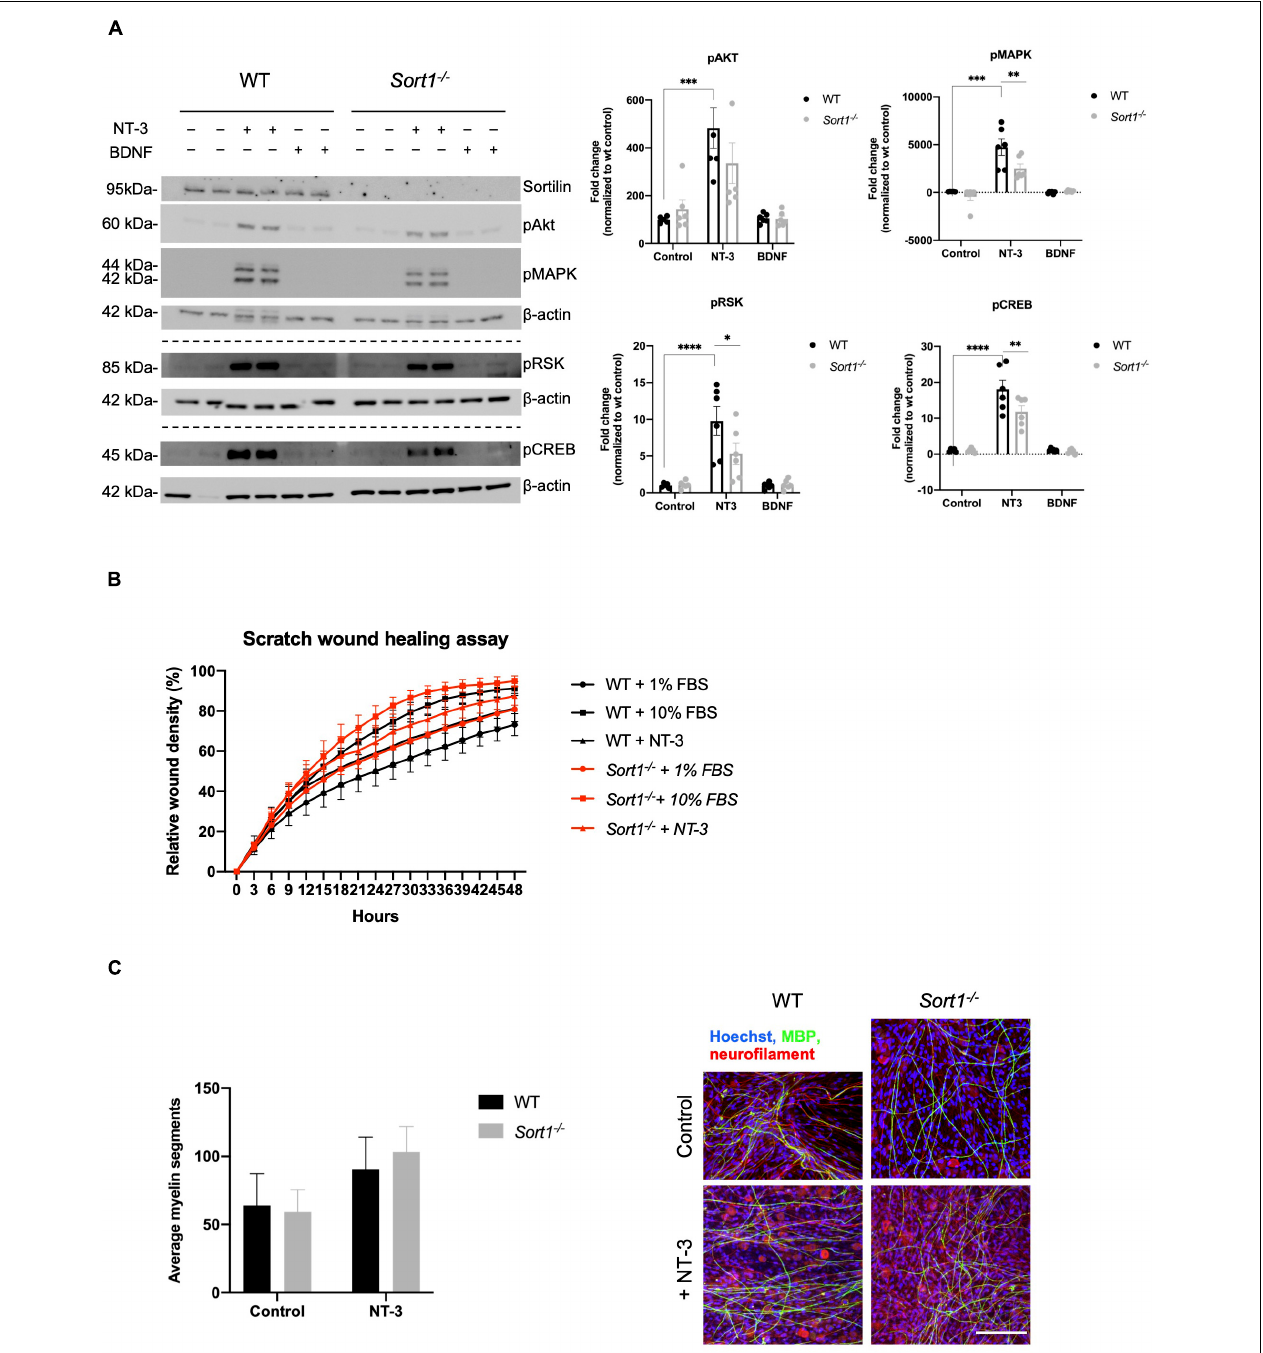
FIGURE 6 | Neurotrophin signaling is decreased in Sort1 − / − Schwann cells. (A) pAkt, pMAPK, pRSK, and pCREB were quantified by densitometry of immunoblots from lysates of NT-3 or BDNF stimulated wild-type (WT) or Sort1 − / − primary cultures of Schwann cells and normalized against β -actin. pMAPK, pRSK, and pCREB levels are significantly lower in Sort1 − / − Schwann cells compared to WT Schwann cells. Data represent the mean ± SEM for n = 3. (B) The relative wound healing closure time was similar in Sort1 − / − Schwann cells relative to WT Schwann cells with or without 10% FBS (positive control) or NT-3. Furthermore, the relative wound healing closure time indicates that NT-3 does not increase the relative wound healing closure time significantly in WT Schwann cells compared to unstimulated controls; 10% FBS significantly increased the relative wound healing closure time at 27–39 h ( ∗ p < 0.05). (C) Sort1 − / − Schwann cells showed similar myelin formation relative to WT Schwann cells. Co-cultures of DRG neurons and Schwann cells were fixed 11 days after myelin induction with or without NT-3 stimulation. The myelin segments were identified with an antibody against myelin basic protein (MBP; green) and the neurites were identified with antibodies against neurofilament (red). Hoechst identifies nuclei (blue). Statistical significance was determined by two-way ANOVA with Bonferroni’s multiple comparisons post hoc test. Data represents mean ± SEM, n = 3 ( ∗ p < 0.05, ∗∗ p < 0.005, ∗∗∗ p < 0.001, ∗∗∗∗ p < 0.0001).